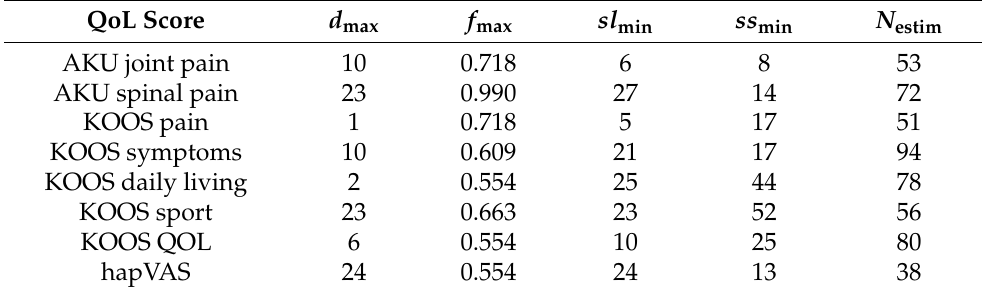
Table 1. List of optimized hyperparameters for RF used in the analysis, for the different QoL